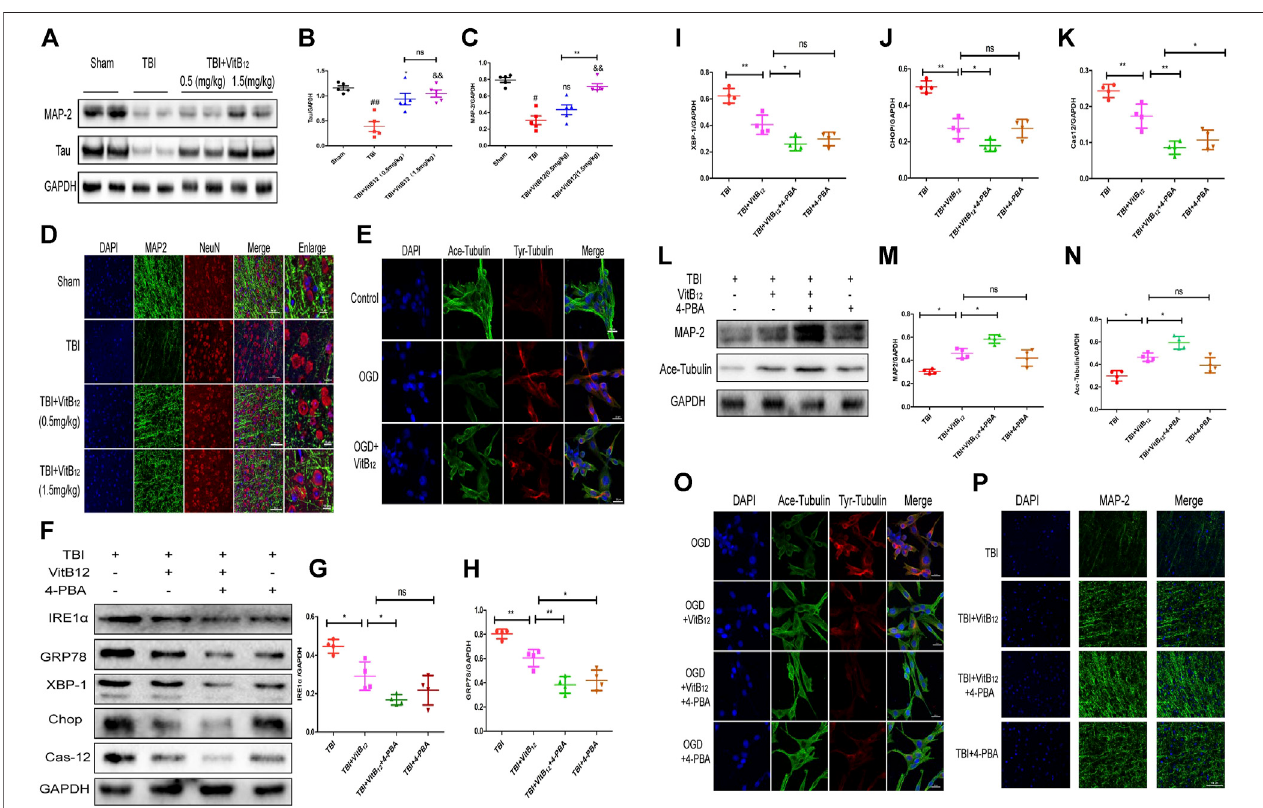
FIGURE 4 | Vitamin B12 inhibits microtubule damage through ER stress after TBI. (A) Representative western blots of the expression of MAP-2, Tau. (B, C) Quanti fi cation from (A) .## p < 0.01, # p < 0.05 vs. the sham group. * p < 0.05, && p < 0.01 vs. the TBI group. ** p < 0.01 vs. the indicated group. Values represent the mean ± SEM, n (cid:1) 5. (D) Representative fl uorescent images depicting MAP-2 (green) with NeuN (red) in the cortex after TBI. Scale bar (cid:1) 50 μ m, scale bar (cid:1) 10 µm. (E) Representative fl uorescent images depicting Ace-tubulin(green) with Tyr-tubulin(red) in the PC 12 cells. Scale bar (cid:1) 20 µm. (F) Representative western blots of the expression of IRE1 α , GRP78, XBP-1, Chop, Cleaved-cas12. (G – K) Quanti fi cation from (F) * p < 0.05, ** p < 0.01 and *** p < 0.001 vs. the indicated group. Values represent the mean ± SEM, n (cid:1) 4. (L) Representative western blots of the expression of MAP-2, Ace-tubulin. (M – N) Quanti fi cation from (L) .* p < 0.05 vs. the indicated group. Values represent the mean ± SEM, n (cid:1) 4. (O) Representative fl uorescent images depicting Ace-tubulin(green) with Tyr-tubulin(red) in the PC 12 cells. Scale bar (cid:1) 20 µm. (P) . Representative fl uorescent images depicting MAP-2 (green) in vivo . Scale bar (cid:1) 50